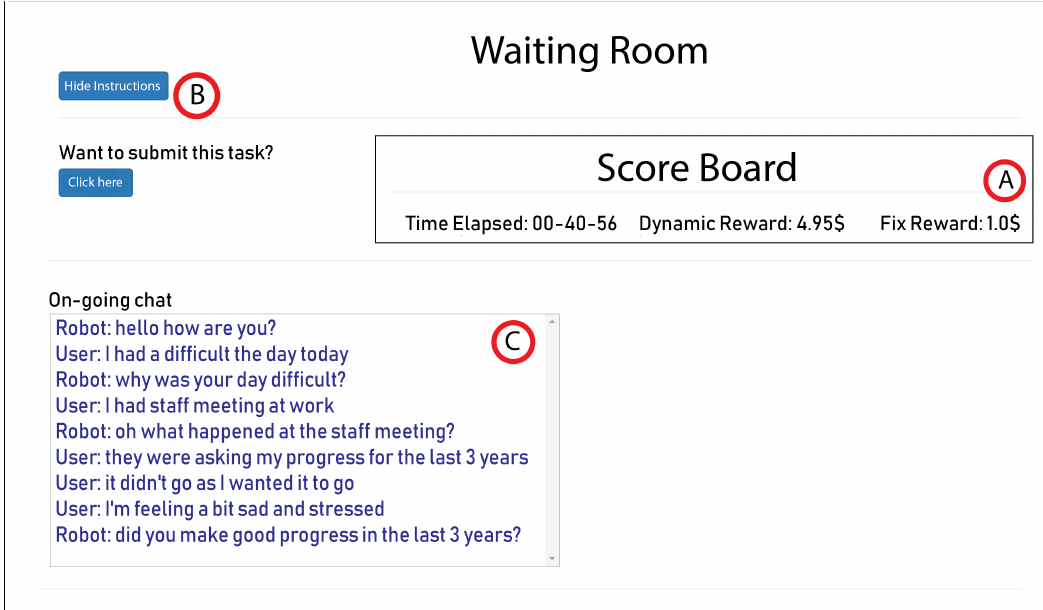
Figure 2. Waiting page where workers are kept to ensure